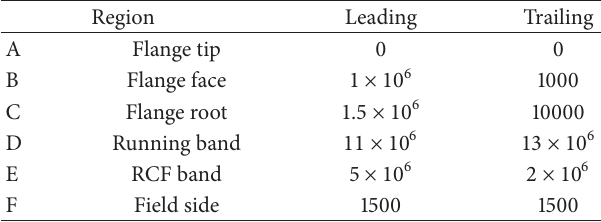
Table 2: Estimated number of stress cycles in each region (shown in Figure 3) of the wheel since last turning ( ≈